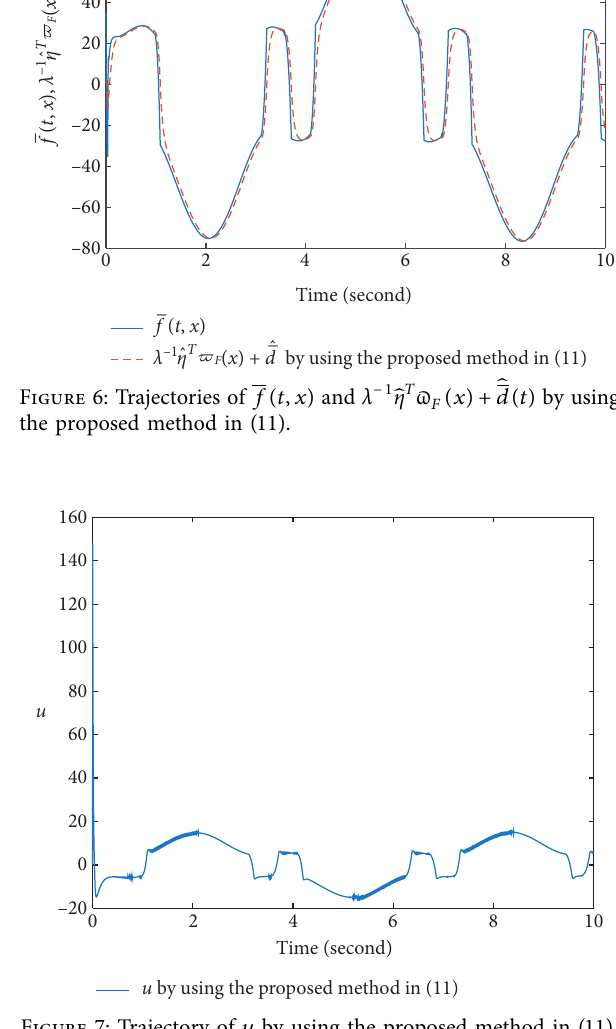
and e by using the proposed method in 1 2